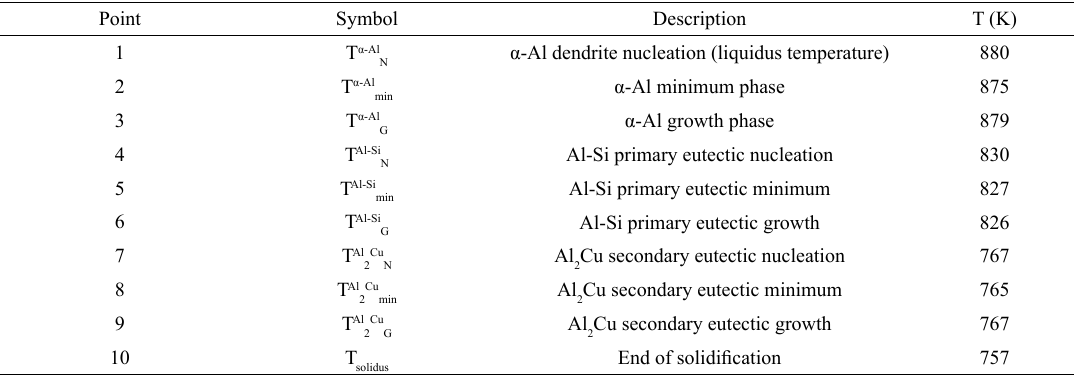
Table 2. The solidification characteristic parameters of phase evolution for Al-5Si3Cu alloy solidified in tec-tip standard cup by thermal analysis.